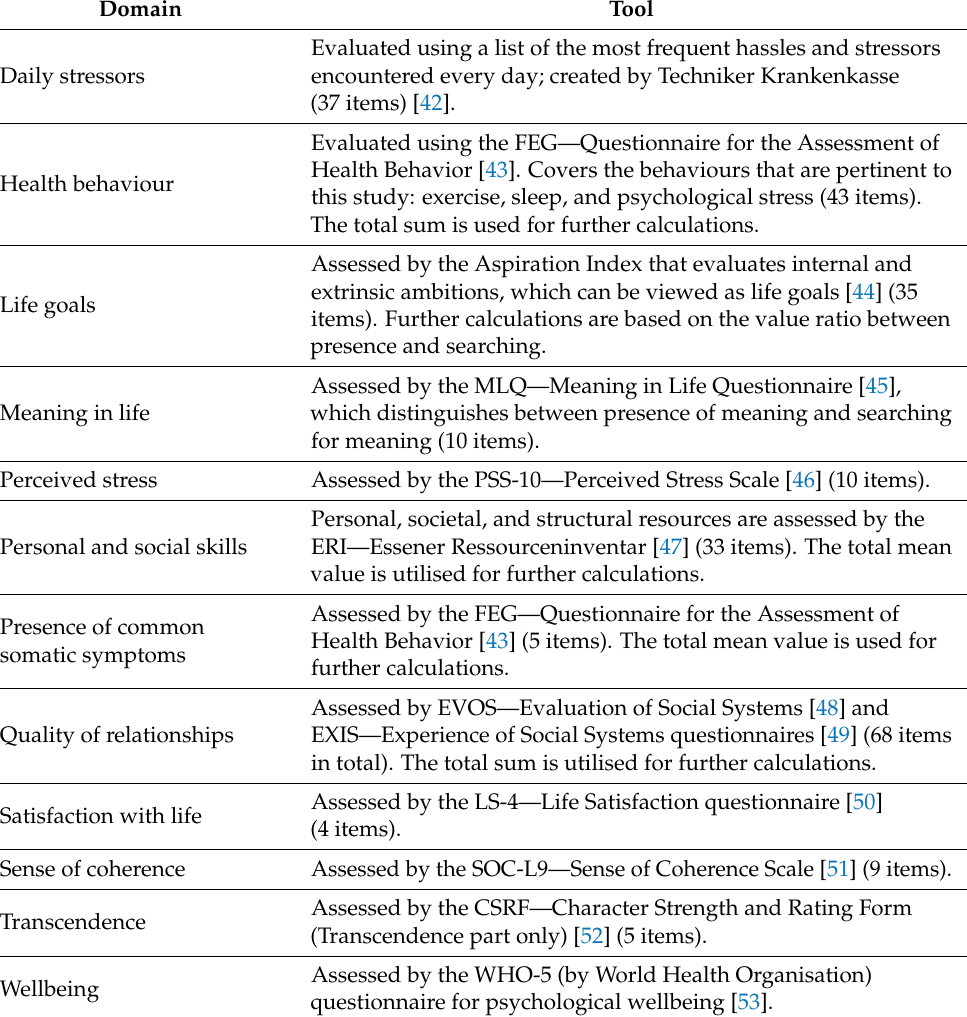
Table 3. Detailed description of the assessment